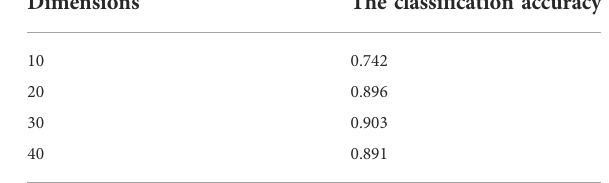
TABLE 7 The comparison of classi fi cation accuracy based on VAE- DBN with different dimensions.